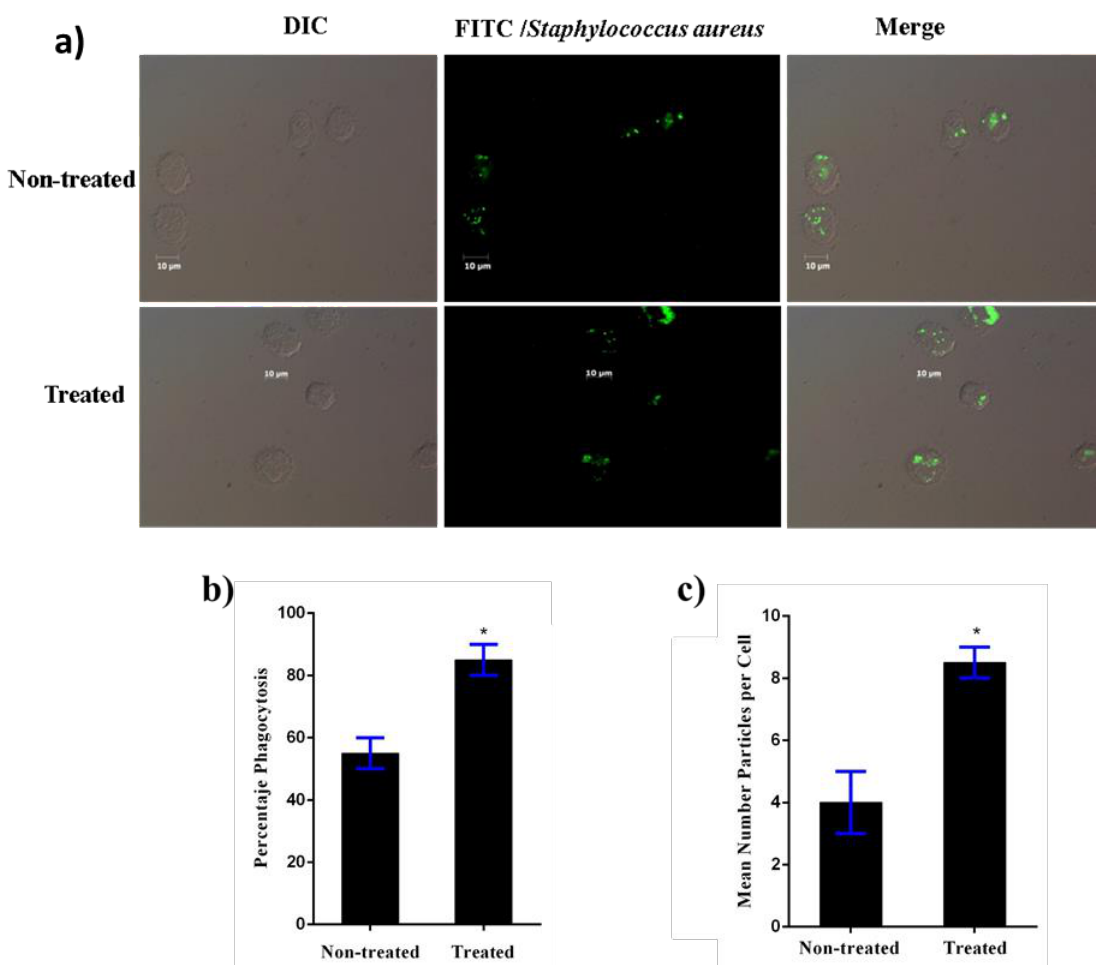
Figure 5. Heat-killed L. casei IMAU60214 increases the phagocytosis of Staphylococcus aureus by MDMs. Phagocytosis was evaluated by counting phagocytic macrophages, and the number of engulfed particles in randomly selected fields of untreated and treated MDMs with L. casei IMAU60214 (at a ratio of 500:1 for 24 h) was challenged with FITC S. aureus at a ratio 10:1 (bacteria / MDM). ( a ) Di ff erential contrast (DIC) micrograph showing FITC- S. aureus fluorescence in MDMs. ( b ) Percentage of phagocytosis. ( c ) Mean number of particles phagocytized per cell. * A p < 0.05 was considered for statistical significance compared to untreated controls for percentage phagocytosis and mean number particles per cells, respectively.